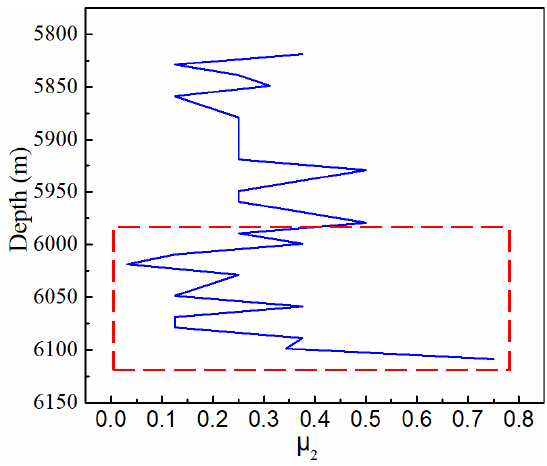
Figure 10. Variation trend of friction coefficient.